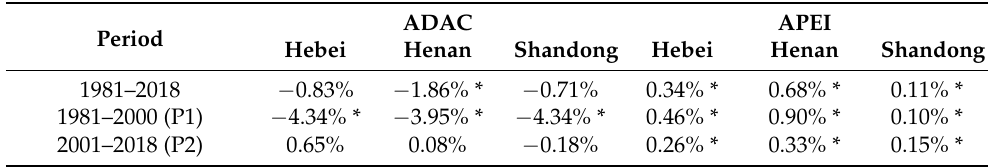
Table 3. Trend change rates of agricultural drought-affected area changes (ADAC) and Area Percent- age Equipped for Irrigation (APEI) during different periods in Hebei, Henan and Shandong